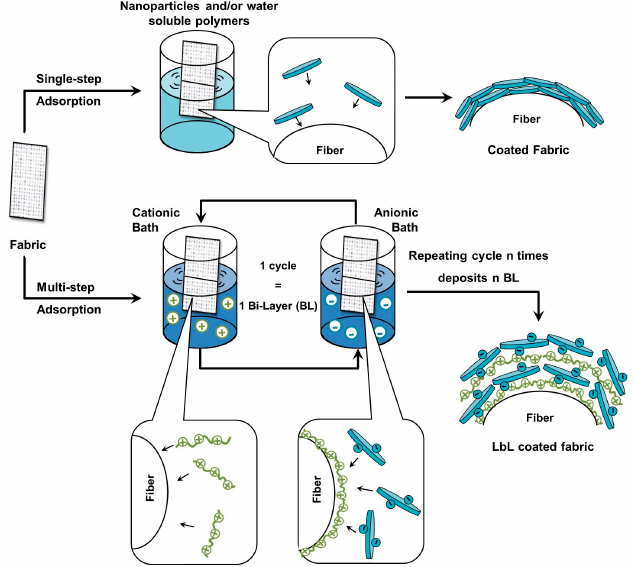
Figure 1. Schematic representation of single- and multi-step deposition techniques presented in this review.